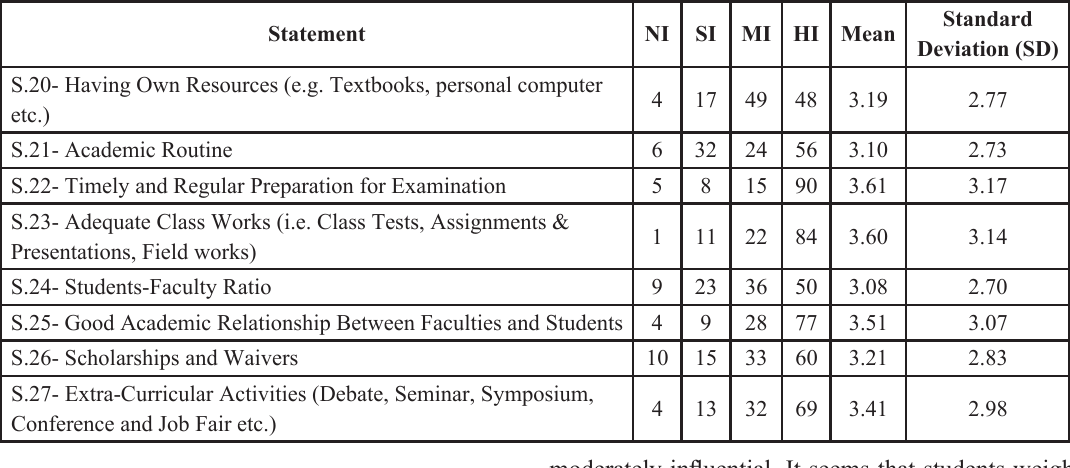
Table 2: Influential Statements and their Outcomes (S.20 to S.27)